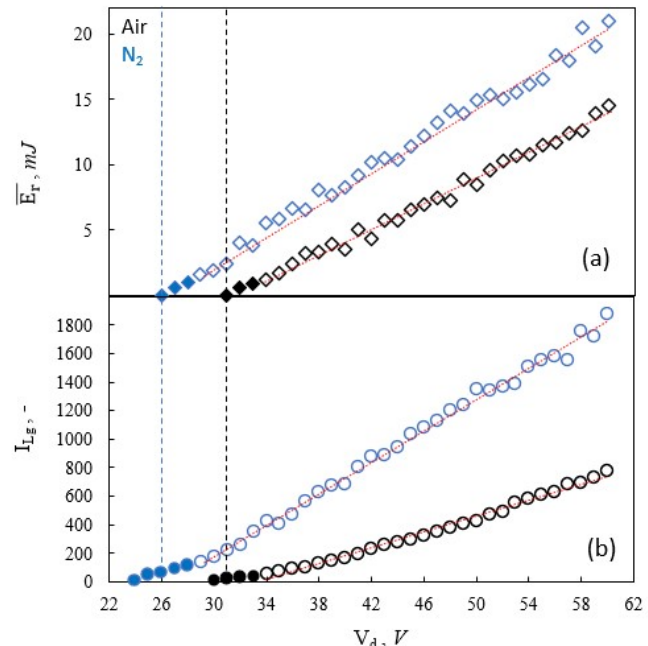
Figure 9. I Lg ( a ) and E r ( b ) versus the driving voltage in air (black markers) and nitrogen (blue markers) at all the voltage level investigated. Dashed black and blue vertical lines depict the voltage threshold over which a measurable release of thermal energy occurs. The dashed red lines represent a linear fit of I Lg for both analyzed media.